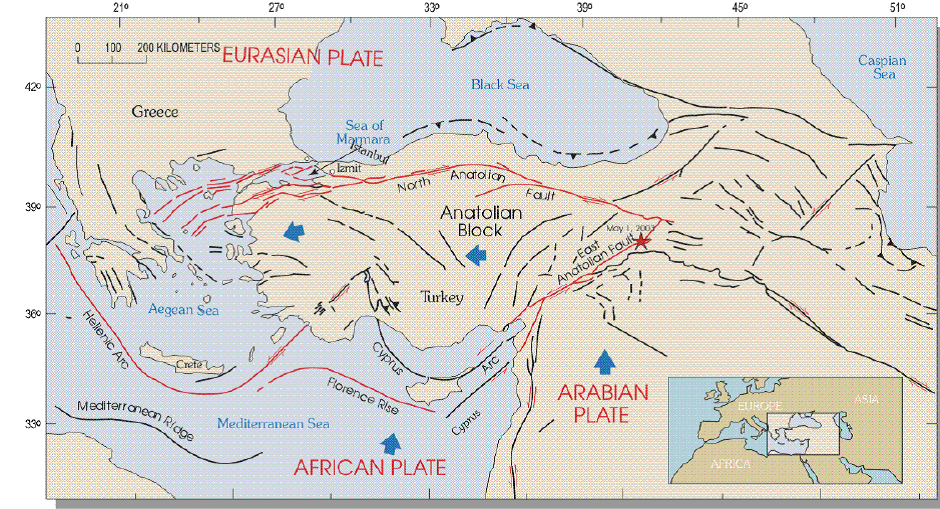
Figure 1. Plate motions in Turkey and the surrounding region (USGS, 2011).